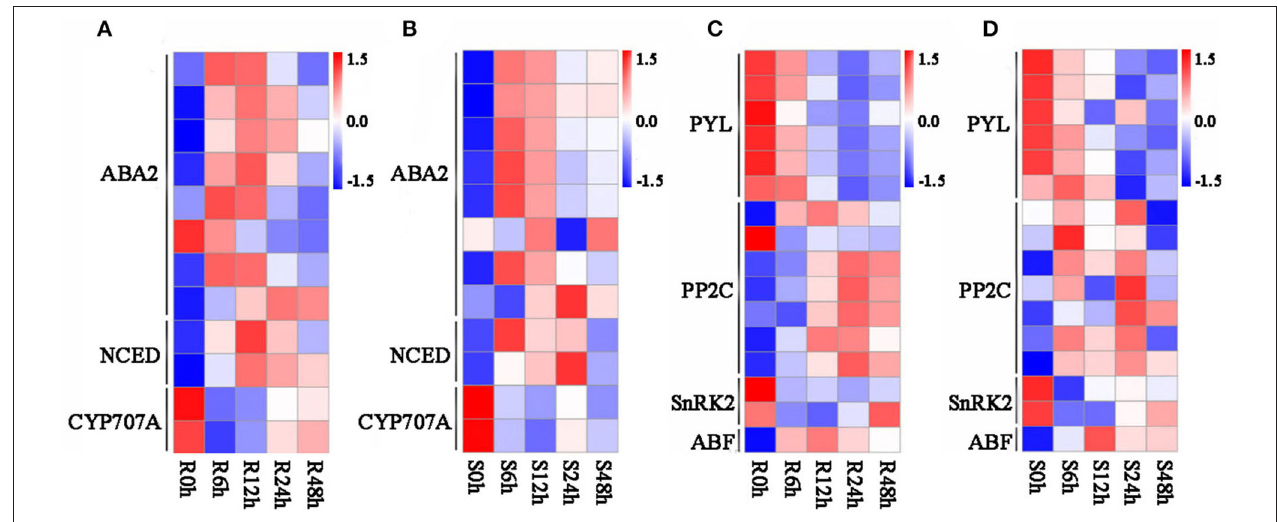
FIGURE 4 | Expression pattern of genes related to ABA biosynthesis and signal transduction. (A) Expression pattern of genes related to ABA biosynthesis in G. raimondii ; (B) expression pattern of genes related to ABA biosynthesis in G. sturtianum ; (C) expression pattern of genes related to ABA signal transduction in G. raimondii ; (D) expression pattern of genes related to ABA signal transduction in G. sturtianum. R0h, Callus of G. raimondii under salt stress for 0h; R6h, Callus of G. raimondii under salt stress for 6h; R12h, Callus of G. raimondii under salt stress for 12h; R24h, Callus of G. raimondii under salt stress for 24h; R48h, Callus of G. raimondii under salt stress for 48h (both here and